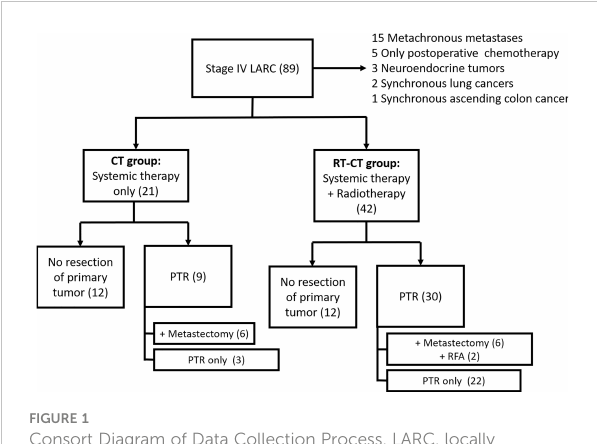
FIGURE 1 Consort Diagram of Data Collection Process. LARC, locally advanced rectal cancer; PTR, primary tumor resection; and RFA, radiofrequency